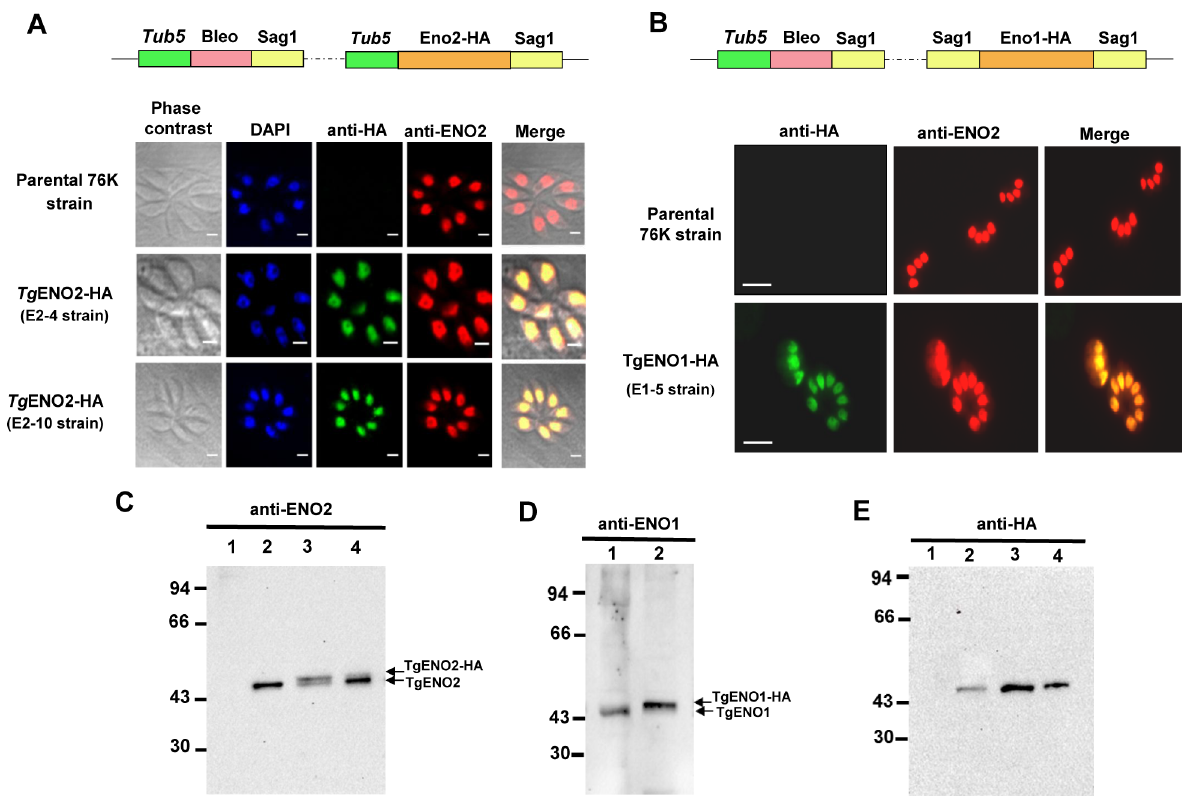
Figure 1. Ectopic expression of TgENO2-HA and TgENO1-HA in wild type T.gondii 76K tachyzoites confirms predominant nuclear enolase localization. A) Schematic representation of the vector used for stable ectopic expression of TgENO2-HA in parasite clones. Expression of TgENO2-HA protein driven by the heterologous tubulin gene promoters was demonstrated by co-localization of fluorescent images using anti-HA and anti-ENO2 antibodies. Similar to endogenous TgENO2 protein, ectopic TgENO2-HA was exclusively localized in the nucleus of two stable clones (E2-4 and E2-10) selected after bleomycin treatment. B) Schematic representation of the vector used for stable ectopic expression of TgENO1-HA in parasite clones. Expression of TgENO1-HA protein driven by heterologous tubulin gene promoters was demonstrated by co-localization of fluorescent images obtained using anti-HA and anti-ENO1 antibodies. Similar to endogenous ENO1 protein, TgENO1-HA protein was exclusively localized in the nucleus of one stable clone (E1-5) selected after bleomycin treatment. C) Western blots of transgenic and ectopically expressed TgENO2-HA protein. Total protein extracts from E2-4 and E2-10 tachyzoites were loaded in lanes 2 and 3 and probed with anti-ENO2. Lane 2 contained total protein from wild-type 76K T. gondii tachyzoites. Lane 1 corresponds to total protein extract from encysted bradyzoites isolated from the brain of mice chronically infected with wild type T. gondii 76K strain. C) Western blots of transgenic and ectopically expressed TgENO1-HA protein. Total SDS-extracted proteins from E2-4 and E2-10 transgenic tachyzoites were loaded in lanes 3 and 4 and probed with anti-ENO2 antibodies. Lane 2 contained total SDS-extracted proteins from wild-type 76 K T. gondii tachyzoites and lane 1 corresponds to total SDS-extracted proteins from encysted bradyzoites isolated from the brains of mice chronically infected with wild type T. gondii 76K strain. D) Western blot analysis of transgenic and ectopically expressed TgENO1-HA protein. Total SDS-extracted proteins from the E1-5 strain was loaded in lane 2 and probed with anti-ENO1 antibodies. Lane 1 corresponds to total-SDS extracted proteins from encysted bradyzoites as described above. E) Western blots of total SDS-extracted proteins from E1-5, E2-4 and E2-10 tachyzoites were loaded in lanes 2, 3 and 4 and probed with anti-HA antibodies. Lane 1 contained total SDS- extracted proteins from wild-type 76 K T. gondii tachyzoites. (Fig. 1D, lane 2). The endogenous TgENO2 protein in tachyzoites (Fig. 1C, lane 2) and TgENO1 protein of encysted bradyzoites isolated from the brains of chronically infected mice (Fig. 1D, lane 1) were used to monitor the protein levels of these positive controls. The level of nuclear enolases increased in actively dividing tachyzoites of T. gondii its endogenous counterpart in intracellular tachyzoites at 0, 6, 12, 18, 24, 30, or 36 hours post-infection using immunofluorescence confocal microscopy (Fig. 2A and 2B). These kinetic studies revealed that the proportion of ectopic TgENO2-HA and tachyzoites increased from 20% to 60% during the 12-h period of intracellular growth, reaching 70% by 32 h post-invasion